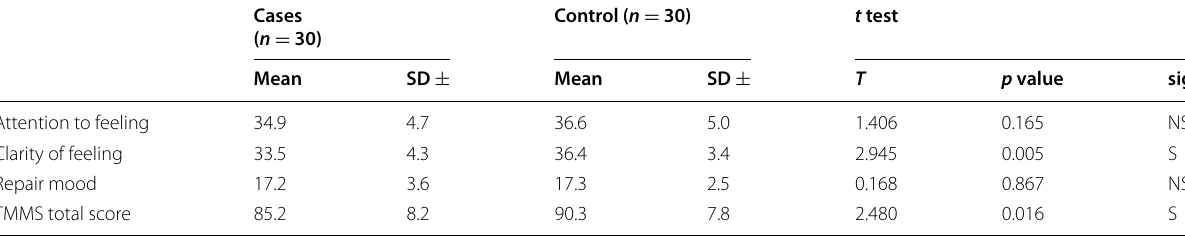
Table 3 Comparison between cases and controls as regards TMMS variables